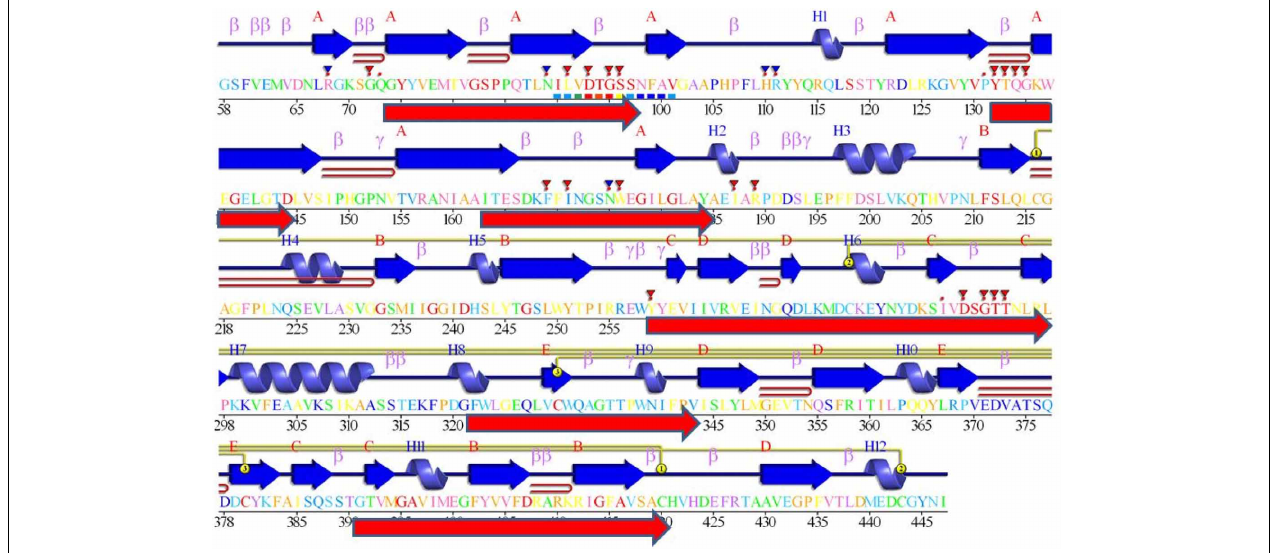
FIGURE 6 | The blocks from Figure 3 and Logos from Figure 4, aligned against a BACE1 PDBSum entry. Among the many entries with different ligands the longest sequence was chosen, 3lpi. The 2D display is shaded red to purple for conserved residues but note these are derived from BACE1